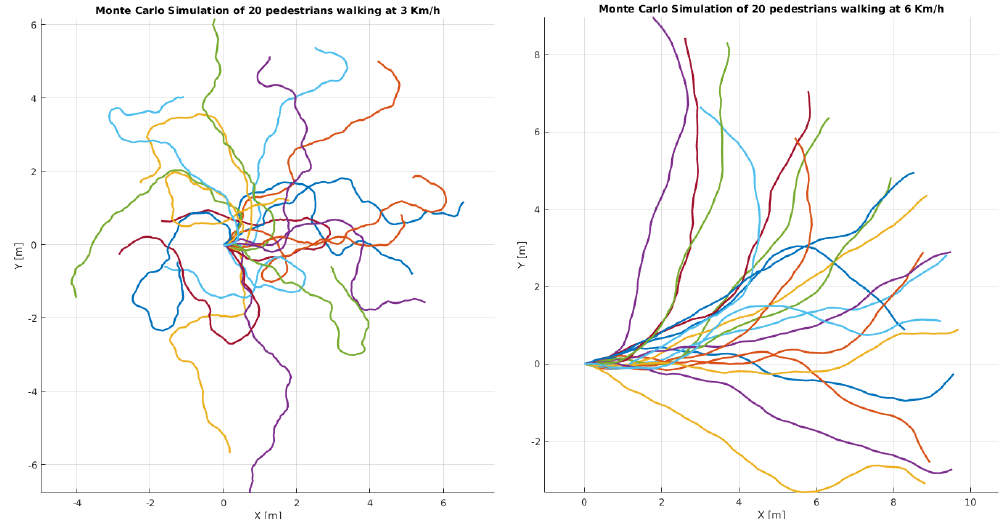
Figure 2. Simulated pedestrian motion on the ground plane using our behavior motion priors learned from the KITTI tracking dataset. Left : 20 particles starting from 3 km/h; Right : 20 particles starting from 6